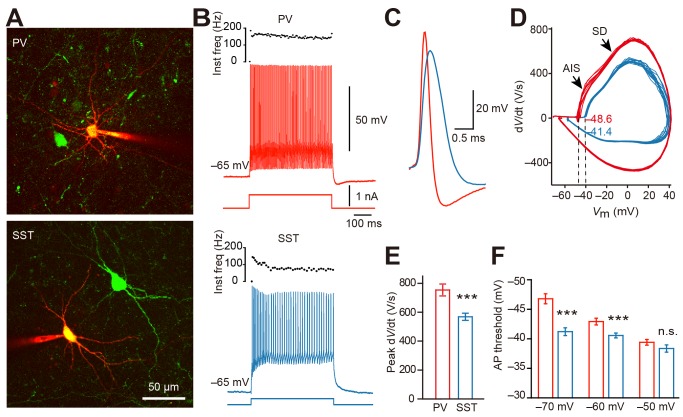
Difference in voltage thresholds of APs in PV and SST neurons.(A) Projection of two-photon images showing recordings from PV-positive (top, B13 mouse) and SST-positive (bottom, GIN mouse) neurons in prefrontal cortical slices. Cells were loaded with Alexa Fluor 594 (red) through patch pipettes. (B) Firing patterns of the two recorded cells shown in (A). Traces are color-coded (PV, red; SST, blue). (C) Overlaid APs from PV and SST neurons. Note the difference in AP waveforms. (D) Phase plots of PV and SST APs evoked by brief current injections. Note the AIS and SD potential components. (E) Difference in peak amplitudes of dV/dt. (F) Dependence of AP thresholds on V
m levels. For (E) and (F), *** p<0.001. Error bars represent s.e.m.